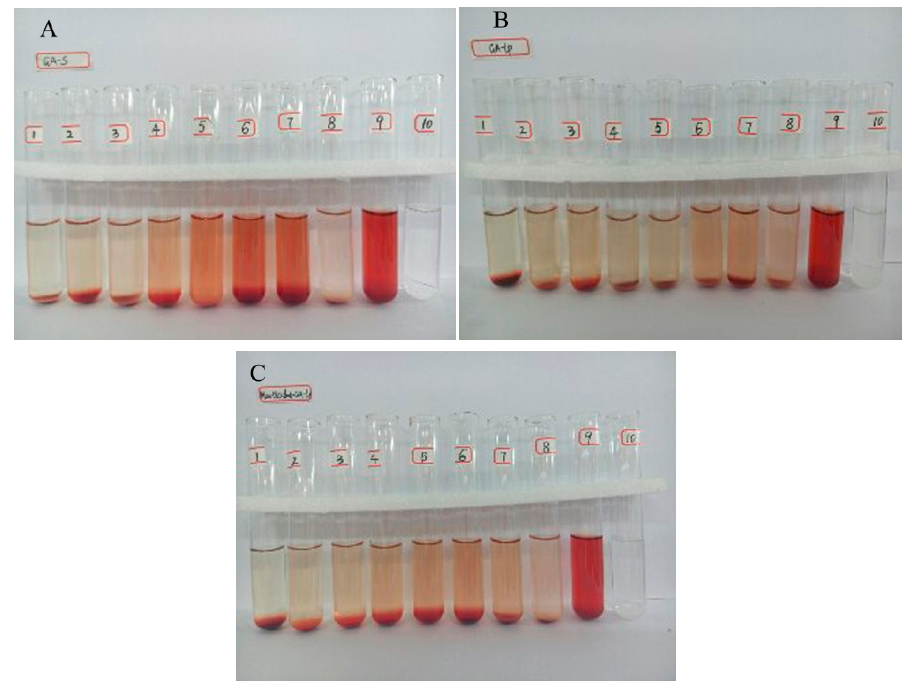
Figure 2. Hemolysis tests of GA-S, GA-Lp, and Man-DLD-Chol-GA-Lp (( A ) GA-S; ( B ) GA-Lp; and ( C ) Man-DLD-Chol-GA-Lp).